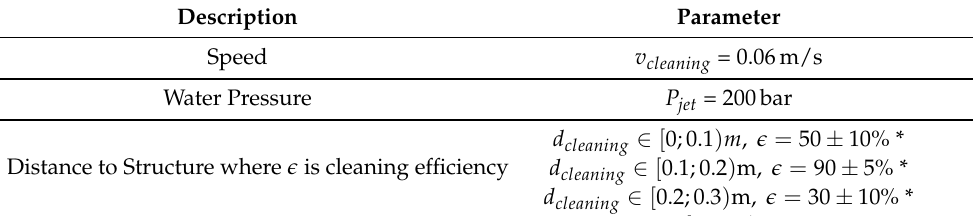
Table 1. Parameters affecting cleaning efficiency. Description Parameter Speed v cleaning = 0.06m/s Water Pressure P jet = 200bar